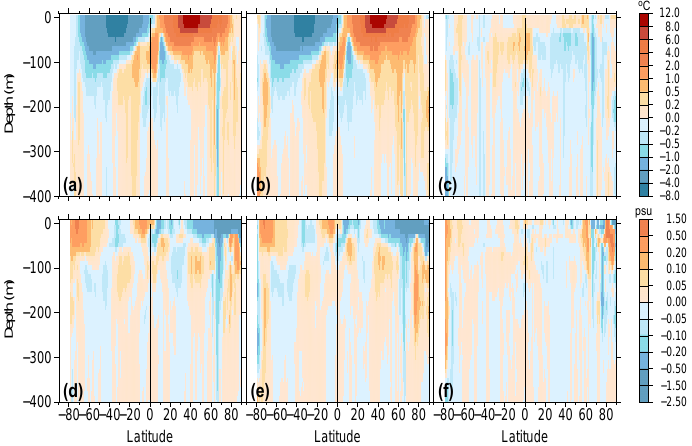
Figure 17. Zonally averaged September minus March differences vs. depth for (a) WAGHC temperature, (b) WOA13 temperature; (c) dif- ference a − b ; (d) WAGHC salinity; (e) WOA13 salinity; and (f) difference d − e